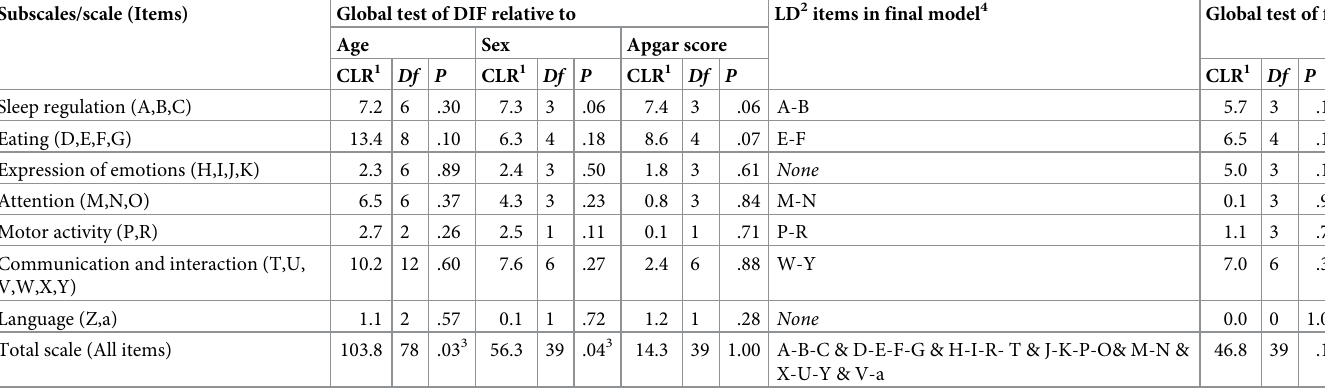
Table 3. Global tests of DIF and global tests of fit in resulting Rasch models (RM) or graphical loglinear Rasch models (GLLRM) for each subscale and the total scale of 24 items across domains. Subscales/scale